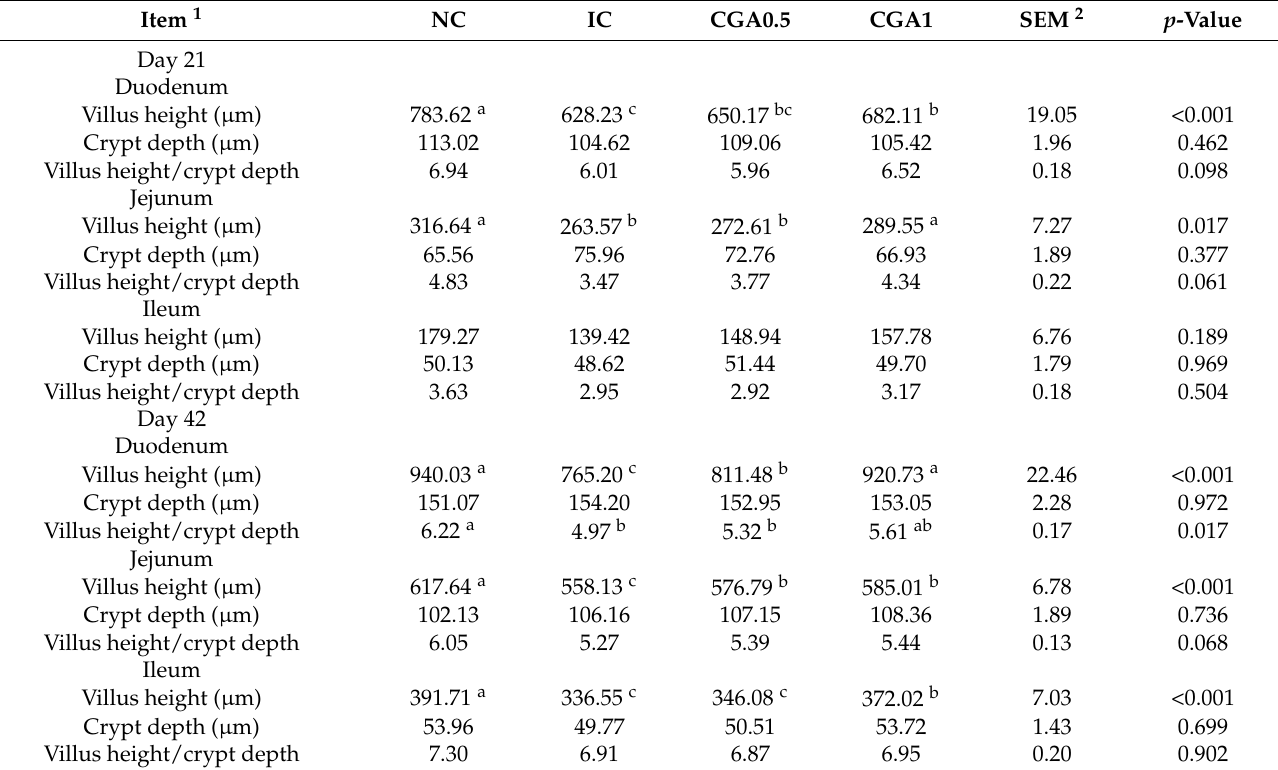
Table 7. Effects of chlorogenic acid (CGA) on the intestinal morphology of broilers ( n =